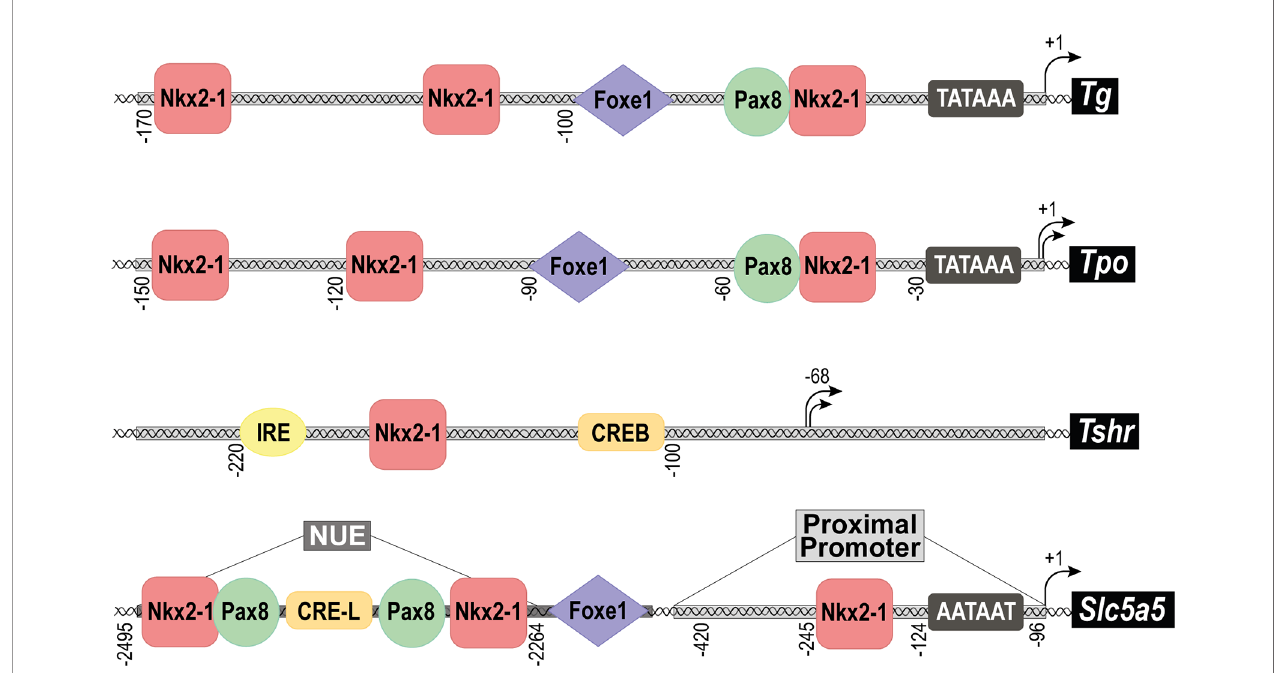
FIGURE 3 | Structure of the promoter regions of the main thyroid differentiation genes. Schematic representation of the main transcription factor binding sites found in the promoter regions of the genes: Thyroglobulin ( Tg ), Thyroid peroxidase ( Tpo ), TSH receptor ( Tshr ) and Sodium/iodide symporter ( Nis, Slc5a5 ). In the case of Slc5a5 , the proximal promoter, and the Nis Upstream Enhancer (NUE) are separately indicated. Black arrows represent the transcriptional initiation site of each promoter and numbers de fi ne its position. The TATA box is indicated as well as the binding sites for transcription factors: Nkx2-1, Foxe1, Pax8, CREB, CRE-L (CRE- Like) and IRE (Insulin Respose